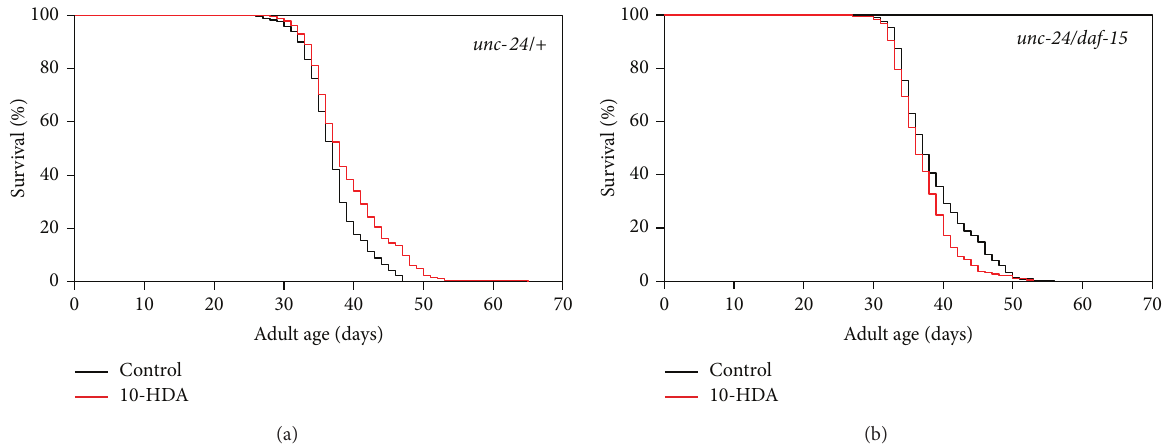
Figure 5: The effect of 10-HDA on the lifespan of the daf-15 mutants. (a) unc-24/ + and (b) unc-24/daf-15 .